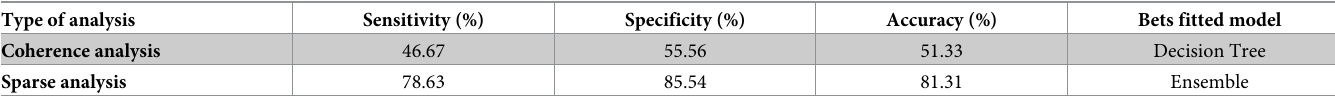
Table 3. Results of applying optimized machine learning approach for multi-tasks